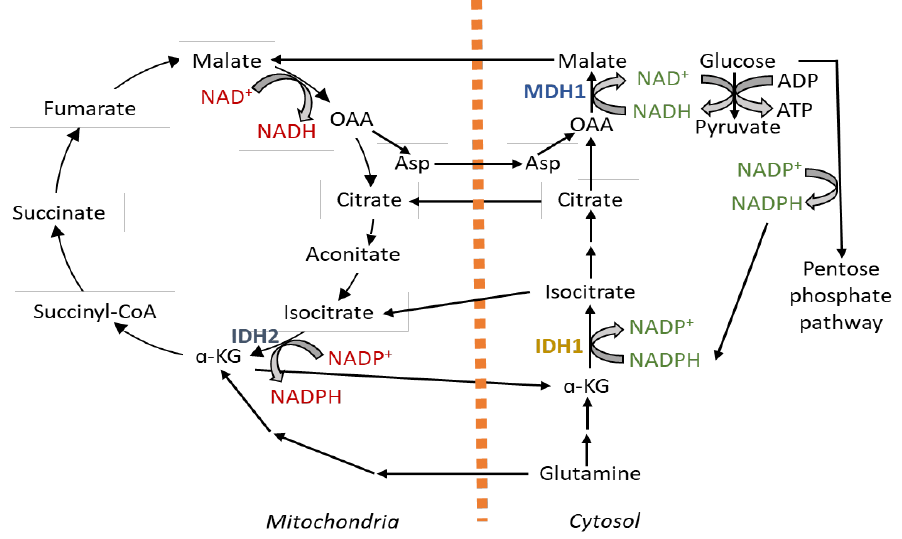
Figure 3. Cytosolic reducing equivalents supporting the mitochondrial redox balance during metastatic dissemination. Glucose and glutamine metabolisms are attenuated during metastatic dissemination to mitigate the accumulation of mitochondrial reactive oxygen species (ROS). Glutamine goes through reductive carboxylation, where isocitrate dehydrogenase 1 (IDH1) consumes NADPH from the cytosol, and citrate generated in this process enters into the mitochondria to support NAPDH production via isocitrate dehydrogenase 2 (IDH2) and fortify the ROS defense. Glucose is metabolized through the pentose phosphate pathway to provide cytosolic NAPDH needed by IDH1. Oxaloacetate (OAA) produced via reductive carboxylation is metabolized by malate dehydrogenase 1 (MDH1) in the cytosol to produce NAD + to support the glycolytic flux. α -KG, α -ketoglutarate; Asp, aspartate.